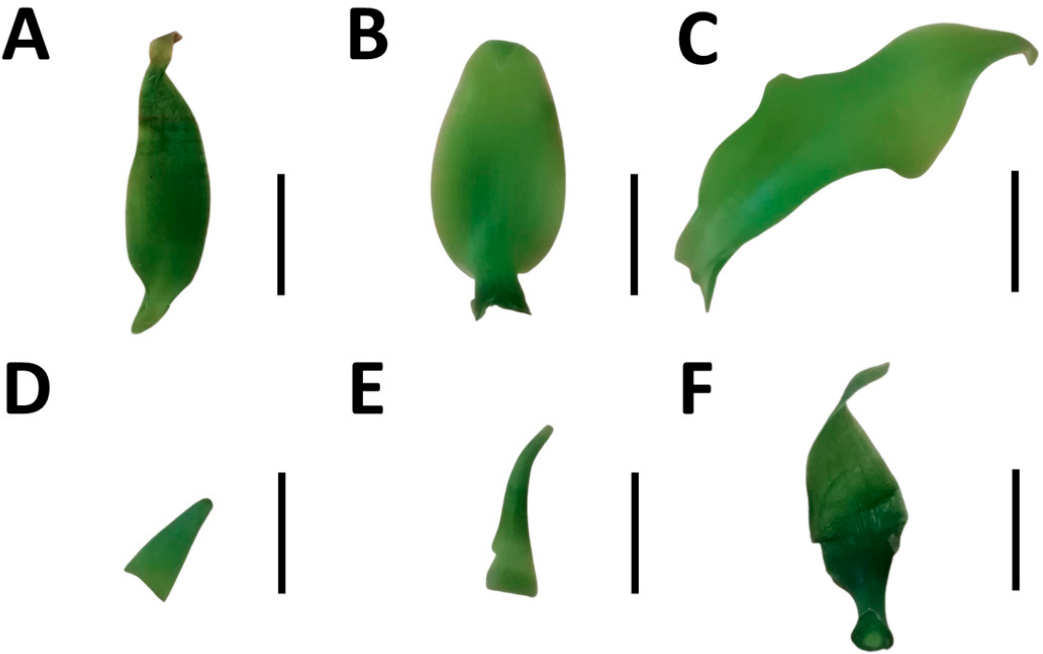
Figure 2. Leaves of vanilla seedlings without and with PEG-induced water stress. ( A , D ) Vanilla planifolia (PL); ( B , E ) V. planifolia × V. pompona (PL × PO); ( C , F ) V. pompona × V. planifolia (PO × PL); ( A – C ) control leaves ( − 0.08 mPa); and ( D – F ) leaves produced under water stress ( − 0.49 mPa). Scale bars = 10 mm.